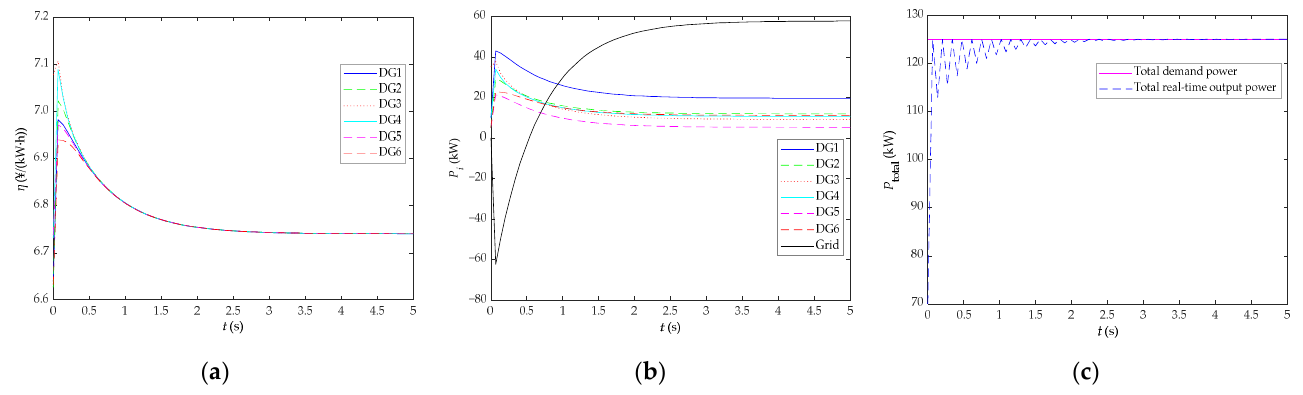
Figure 16. The change curves of variables of the system when ε is increased by 5 times: ( a ) change curves of each DG’s ICR; ( b ) change curves of each DG’s active output and grid output power; ( c ) change curves of the cumulative sum of each DG’s active output and grid output power as well as total demand power.